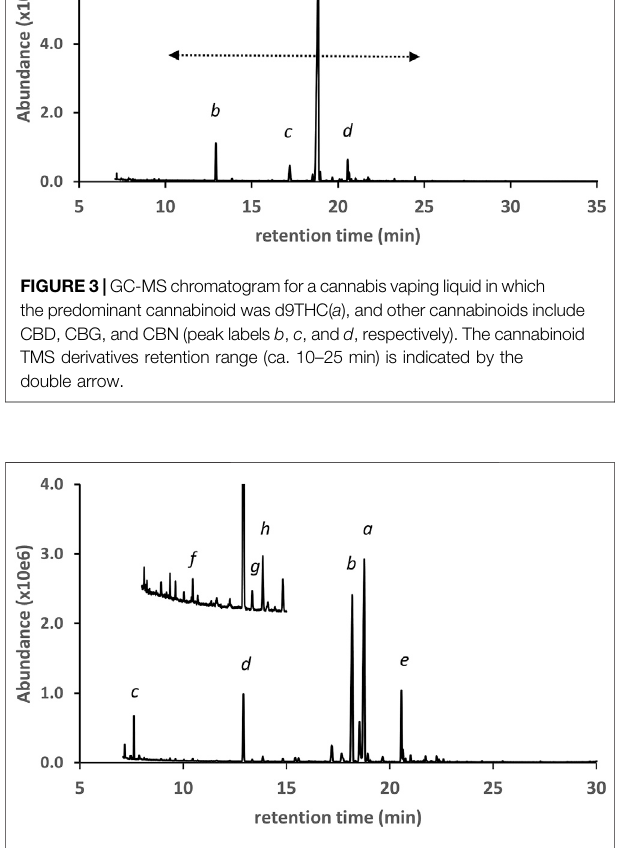
FIGURE4 | GC-MSchromatogram fora cannabis vaping liquid inwhich the predominant cannabinoids were d9THC( a ) and d8THC( b ), with lower levels of CBD( d ) and CBN( e ). A minor level of exoTHC ( not labeled , peak between peaks a and b), and an elevated level of olivetol( c ), were observed. Three corresponding varinols were identi fi ed (expanded scale and offset): CBDV( f ), d8THCV( g ), d9THCV( h ).